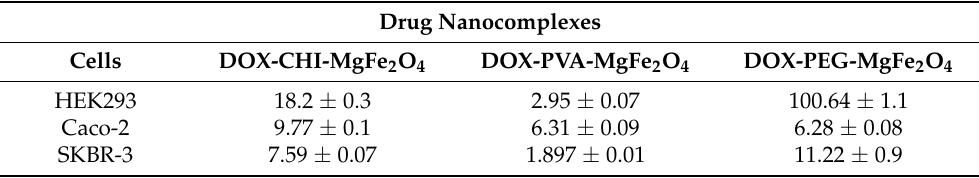
Table 5. IC 50 (µg) values for DOX-loaded MNPs and free DOX.